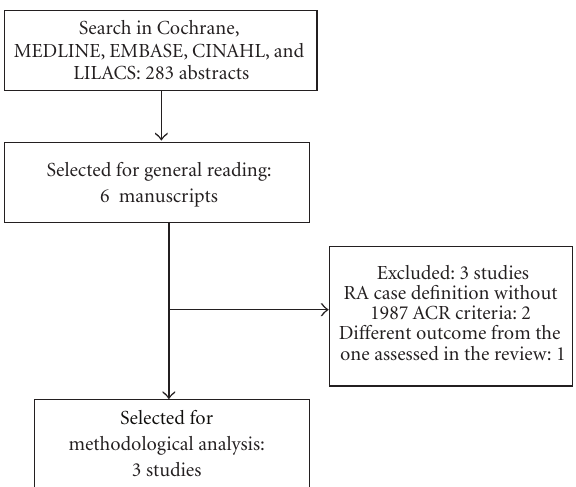
Figure 1: Fluxogram of studies selection. Acronyms: RA: rheuma- toid arthritis; ACR: American College of